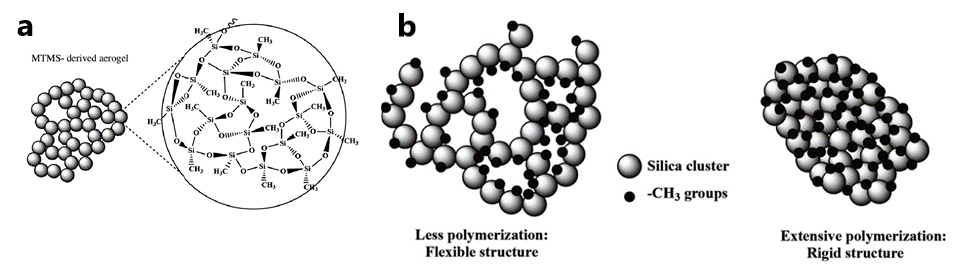
Figure 8. ( a ) Three-dimensional network of MTMS-derived aerogels with its detailed molecular structure. ( b ) Degree of polymerization of silanols exhibiting flexible structure and rigid structure. Reprinted with permission from [75].